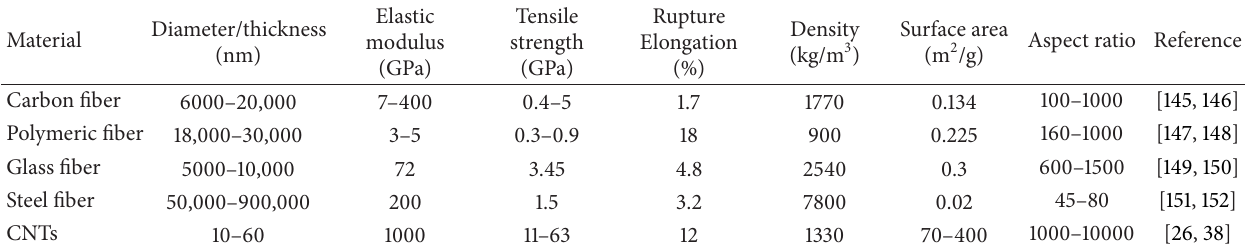
Table 1: Material properties of typical fibers.